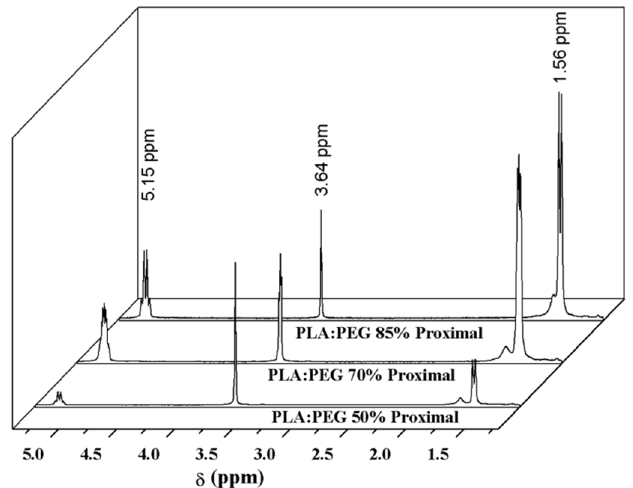
Figure 7. RMN spectra of proximal sections of PLA:PEG specimens with theoretical PEG content of 15%, 30% and 50 wt-%.